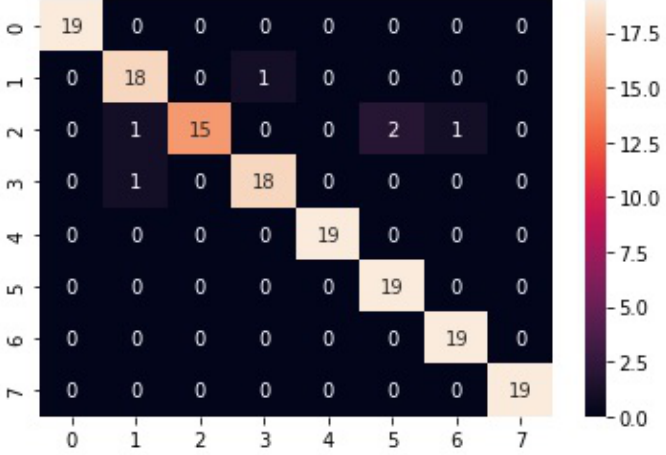
Figure 9. Ontological-bagging-based confusion matrix.